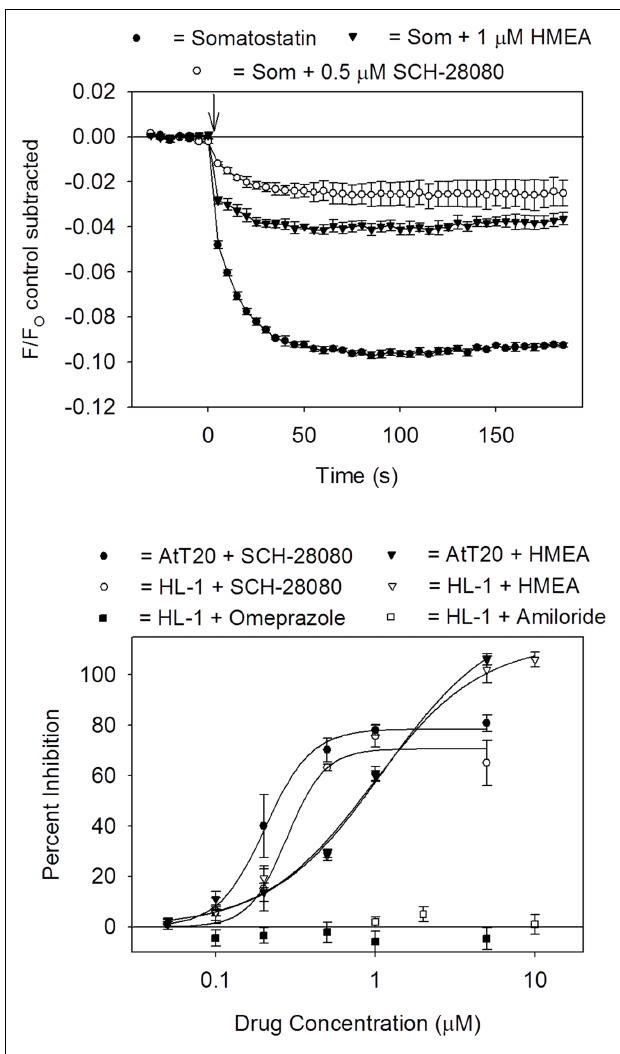
FIGURE 5 | Block of GIRK channels by ion transporter inhibitors. Top panel: somatostatin-sensitive fluorescent signal measured in AtT20 cells pretreated for 5min with drug vehicle solution (DMSO; Som) and either 1 μ M 5-( N , N -hexamethylene)-amiloride (HMEA) or 0.5 μ M SCH-28080. Each point represents the mean ± SE value obtained in six wells in one plate. Bottom panel: dose versus response curve for drug block of the somatostatin (AtT20 cells) or carbachol (HL-1 cells) signal. Each point represents the mean ± SE inhibition obtained from three to